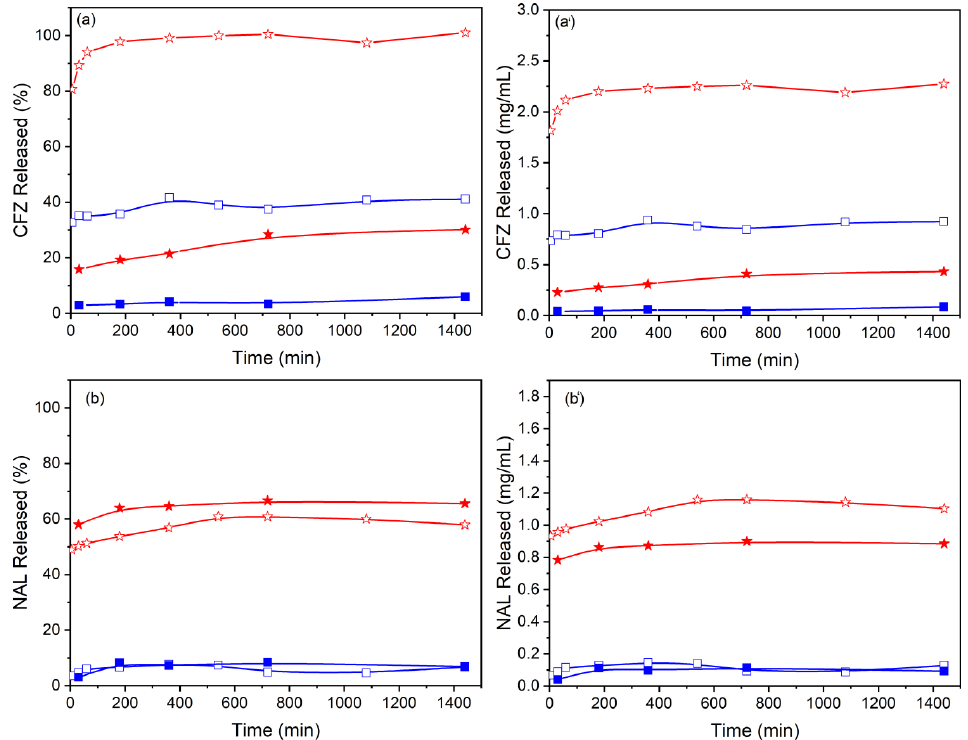
Figure 6. Release profiles of antibiotics in PBS (red) and water (blue) from ZnAl-CFZ (empty symbols) and from Ag/ZnAl-CFZ (full symbols) ( a , a’ ) and from ZnAl-NAL (empty symbols) and Ag/ZnAl-NAL (full symbols) ( b , b’ ).